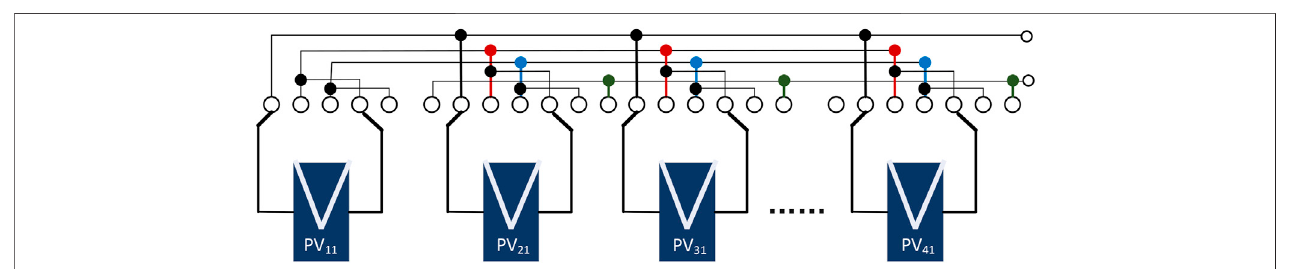
FIGURE 1 | Structure of the proposed switching matrix in